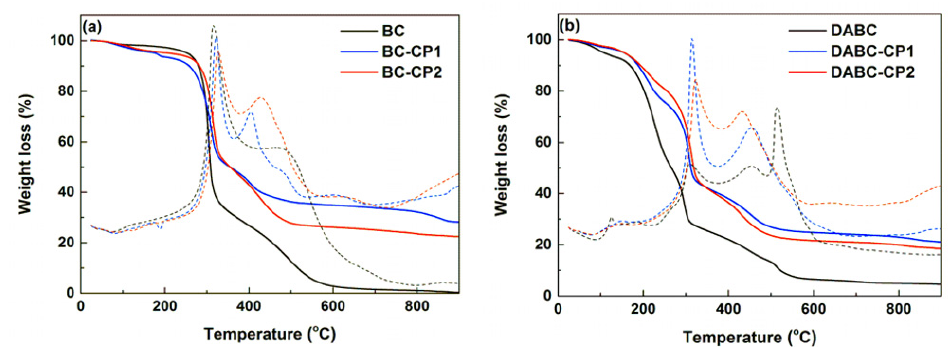
8 of 18 Figure 6 . X ‐ ray diffractograms of ( a ) BC, BC ‐ CP1, and BC ‐ CP2 and ( b ) DABC, DABC ‐ CP1, and DABC ‐ CP2. 2.1.4. Thermogravimetric Analysis The thermogravimetric curves for all studied samples are presented in Figure 7. From these, one can observe common features for all curves (TG and DSC). The first mass loss corresponds to the evaporation of light volatile compounds, especially water, a process accompanied by an endothermic effect on the DSC curve. A degradation process of the polymeric matrix (BC) takes place at approximately 135 °C, which is related to the depol ‐ ymerization, dehydration, and decomposition of the glycosyl units, for which the mass